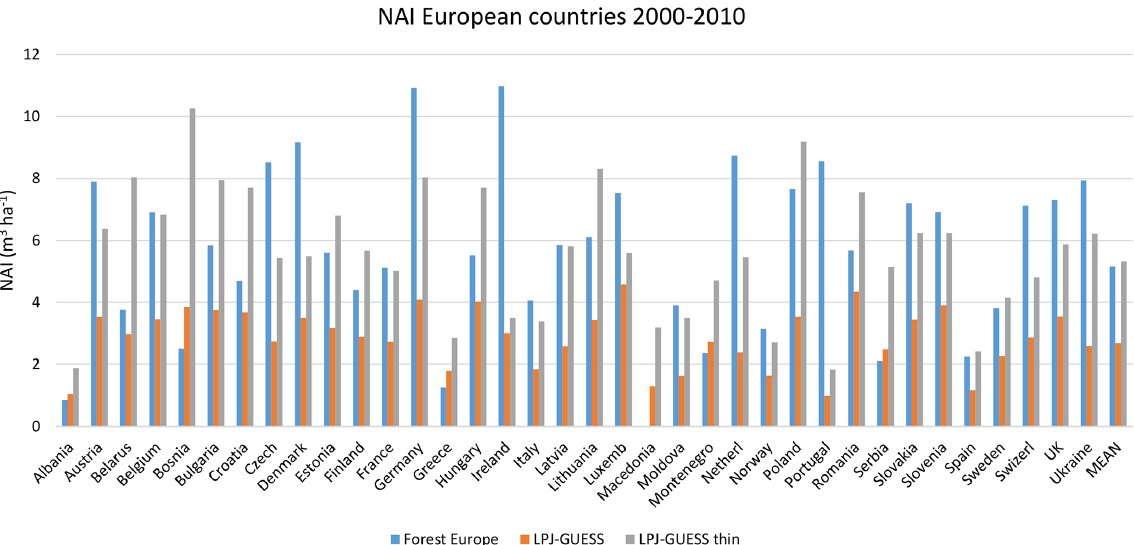
Figure E4. Modelled and observed (Forest Europe, 2015) net annual increment (NAI) for individual countries in 2001–2010. LPJ-GUESS is the simulation without thinning. LPJ-GUESS thin is the simulation with automated